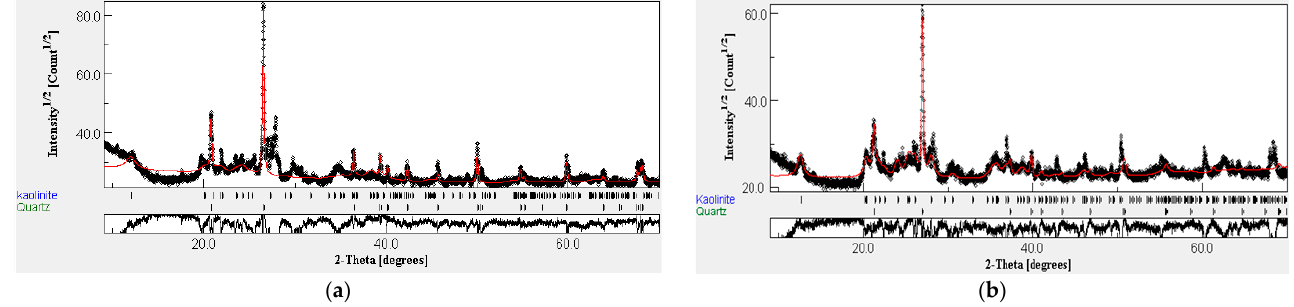
Figure 2. A XRD spectra of Y-Clay ( a ) and L-Clay ( b ).